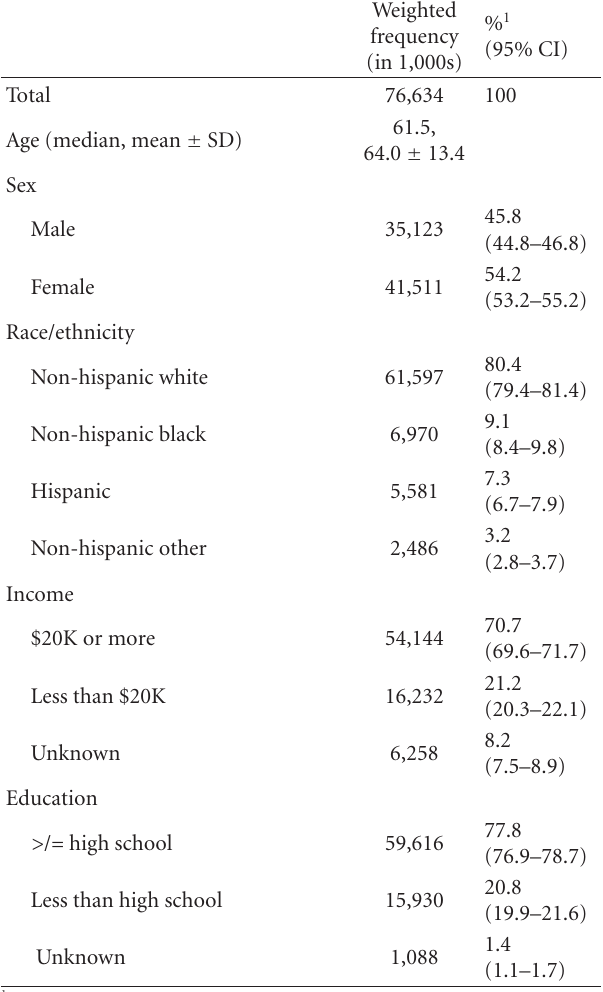
Table 1: Weighted characterization of the study sample of 12,376 USA Adults ≥ 50 years,